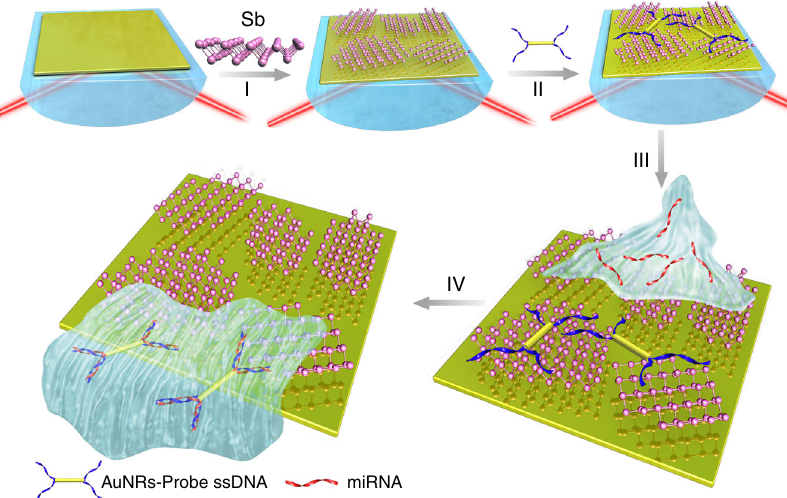
Fig. 2 Fabrication of a miRNA sensor integrated with antimonene nanomaterials. Schematic illustration of the strategy employed to detect antimonene- miRNA hybridization events. I The antimonene nanosheets was assembled on the surface of Au fi lm. II AuNR-ssDNAs were adsorbed on the antimonene nanosheets. III miRNA solution with different concentrations fl owed through the surface of antimonene, and paired up to form a double-strand with complementary AuNR-ssDNA. IV The interaction between miRNA with AuNR-ssDNA results in release of the AuNR-ssDNA from the antimonene nanosheets. The reduction in the molecular of the AuNR-ssDNA on the SPR surface makes for a signi fi cant decrease of the SPR angle